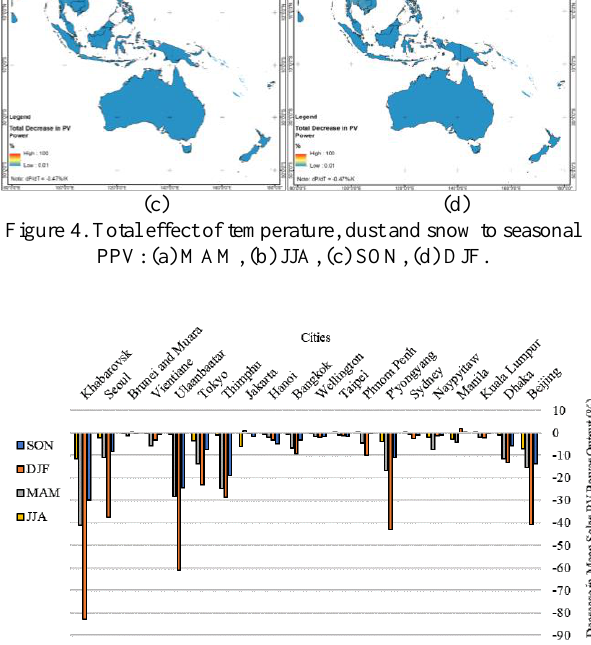
Figure 5. Decrease in mean seasonal solar PV power potential for selected cities in the Asia Pacific region.